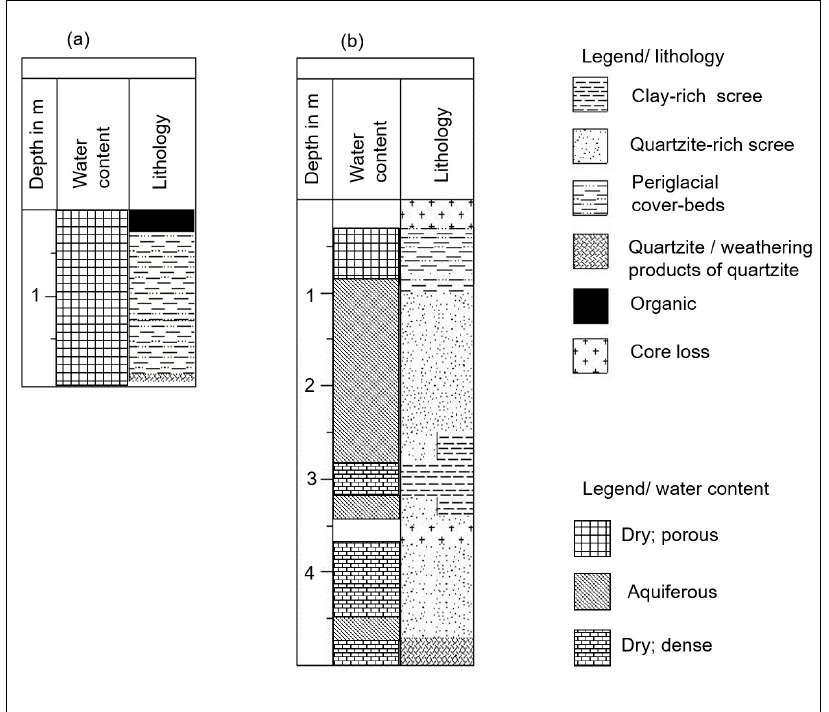
Figure 5. Boreholes: catchment area of "Thranenbruch": ( a ) B1, ( b ) B2.